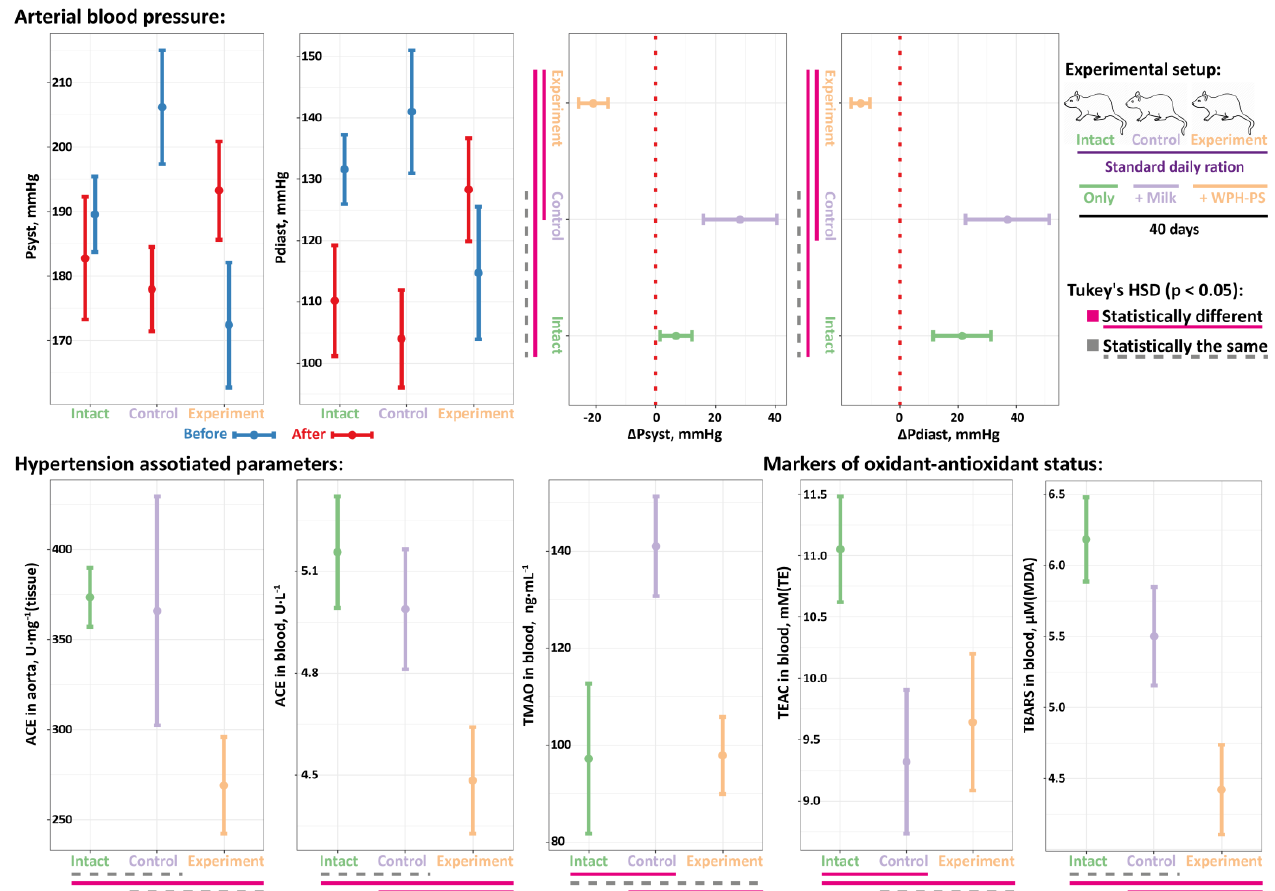
Figure 4. The in vivo assessment of antihypertensive properties for WPH–PS composition using Spontaneously Hyper- tensive Rats (SHRs) animal model. Each group of SHRs (intact, control and experimental) contained 10 animals.